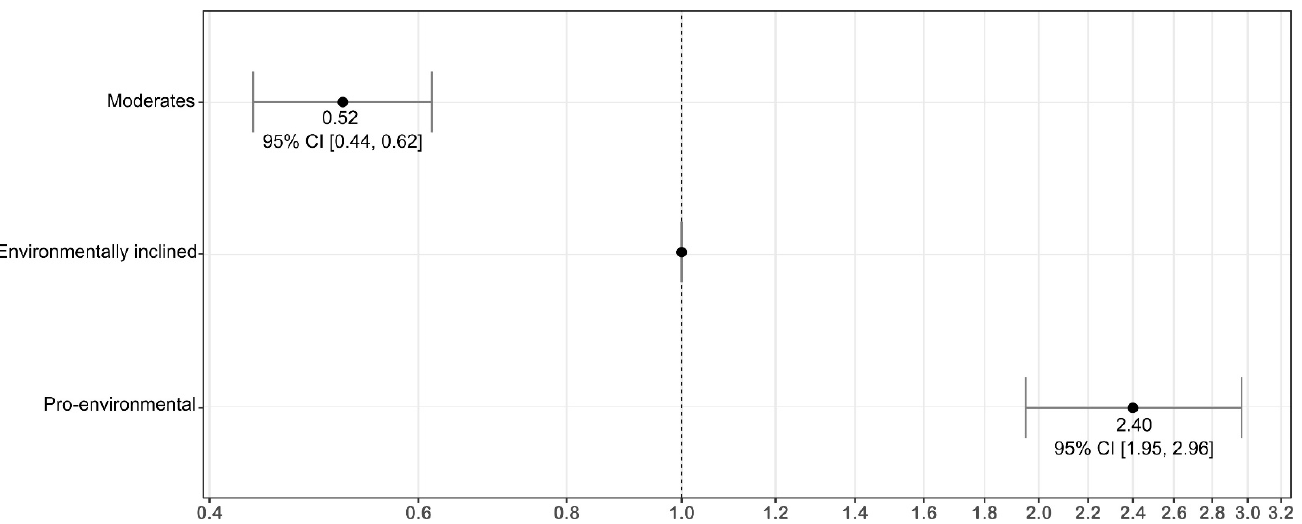
Figure 1. Odds ratios (with 95% CIs) of the latent classes for accepting an implementation of the environmental classification system for pharmaceuticals, presented on a logarithmic scale. Table 4. Utilities of the attribute levels among the respondents and latent